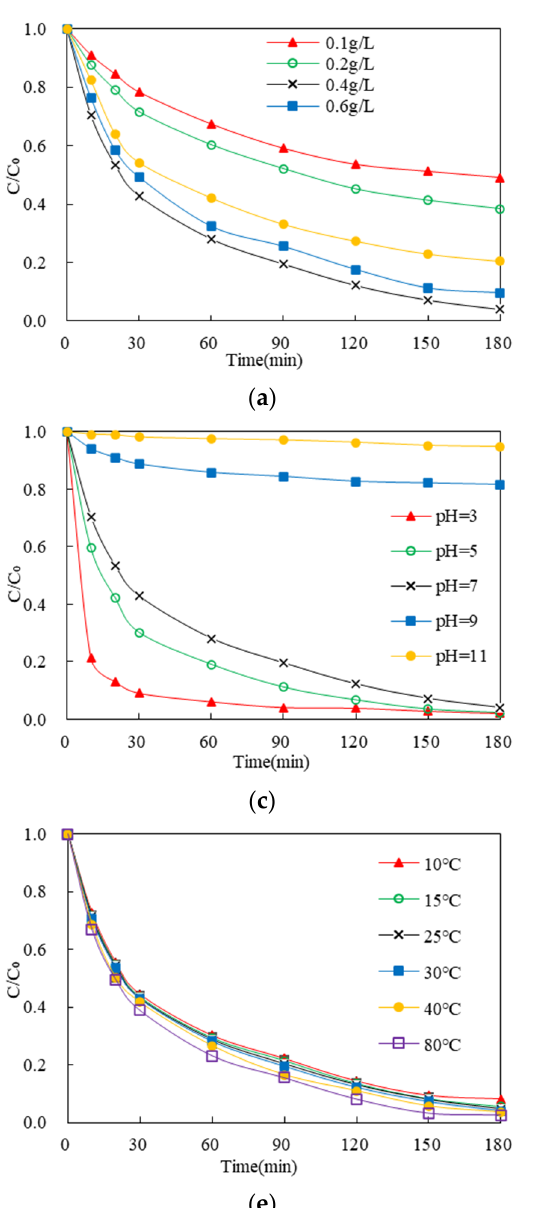
Figure 5. Influence of ( a ) catalyst dose; ( b ) PS concentration; ( c ) initial pH; ( d ) initial 2,4-DCP concentration; ( e ) temperature on degradation of 2,4-DCP.